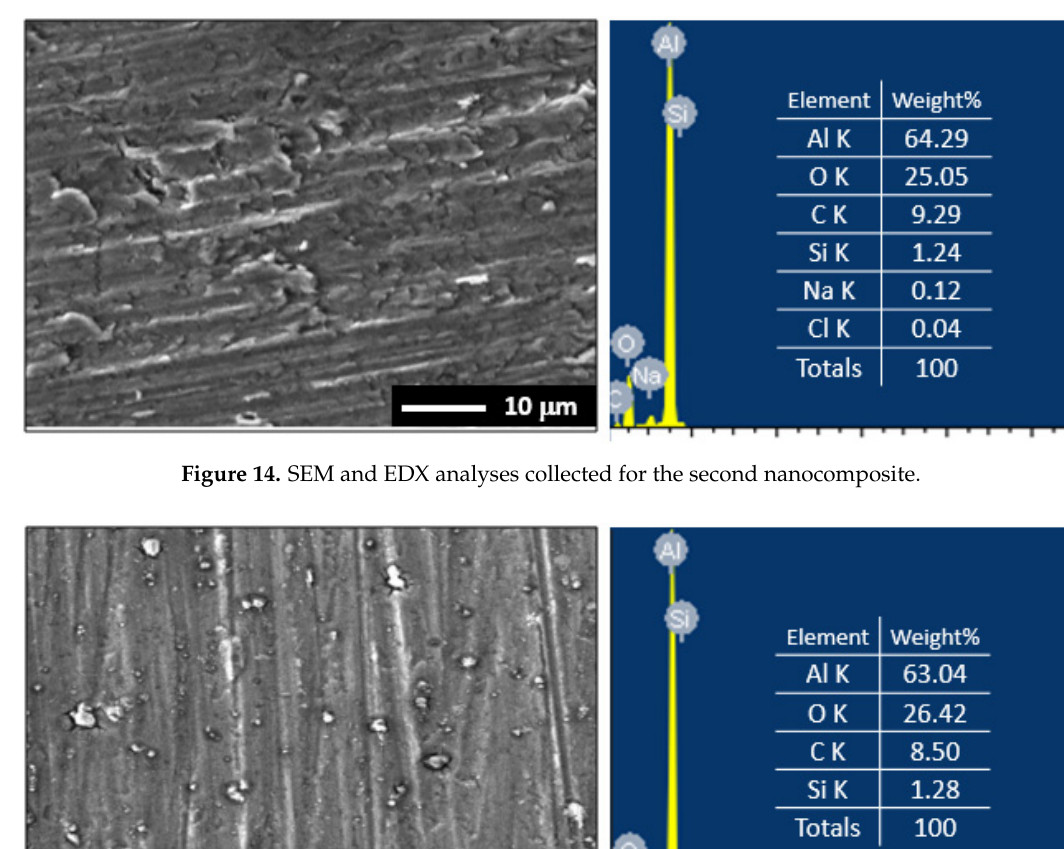
Figure 13. SEM and EDX analyses collected for the first nanocomposite.